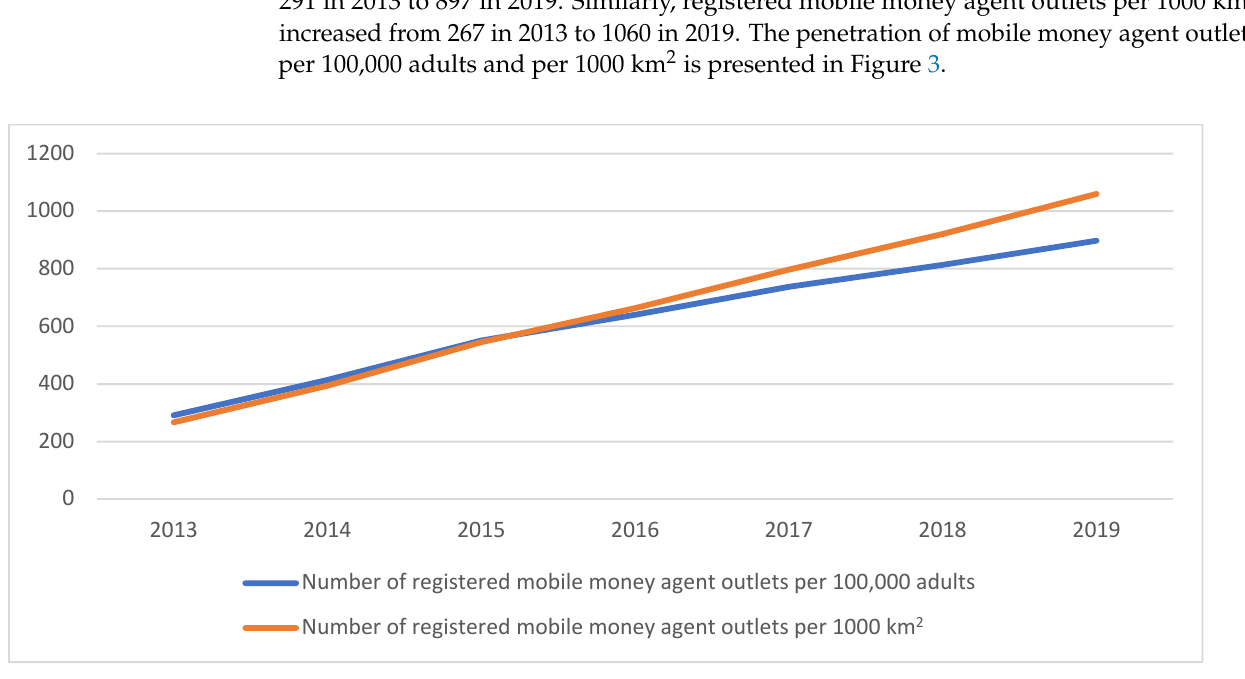
Figure 3. Mobile money agent outlets per 100,000 adults and per 1000 km 2 .